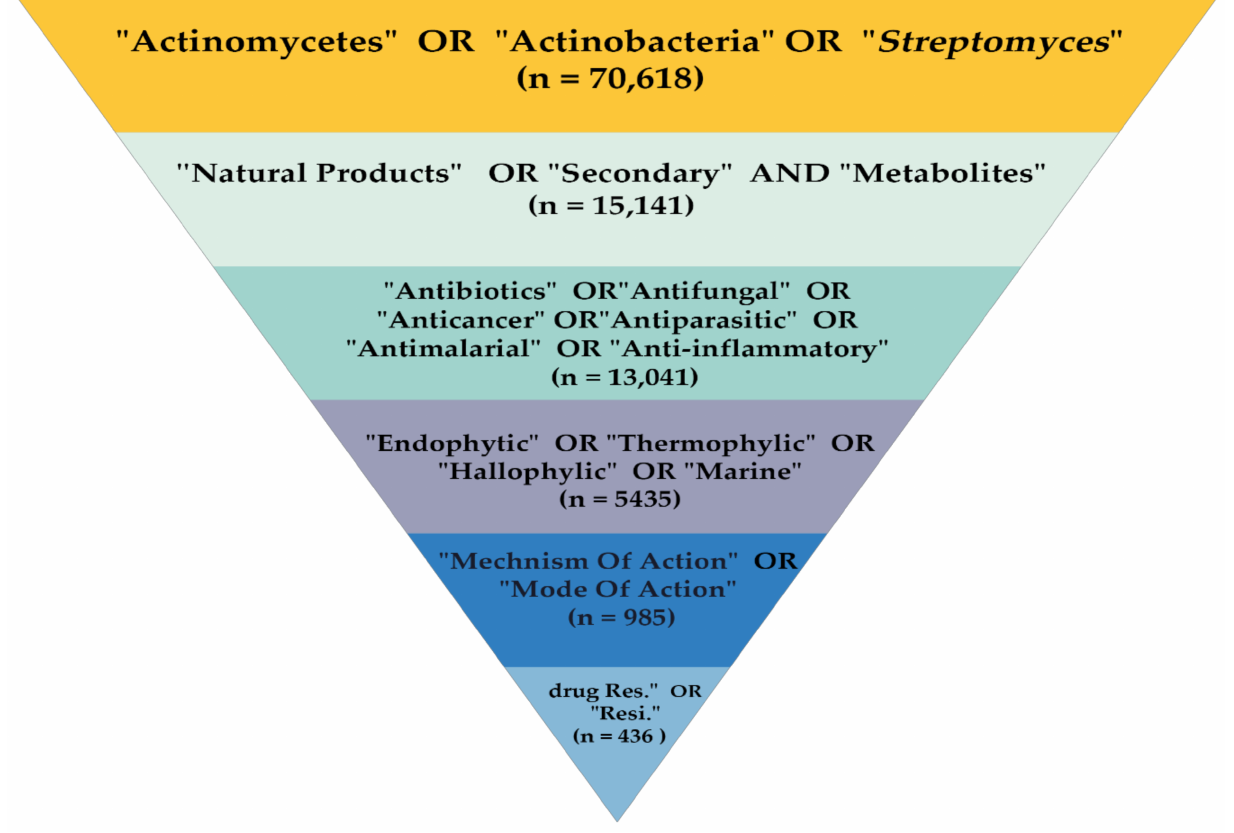
Figure 1. Phases of the review protocol. The process involved six main steps using the general keywords “Actinomycetes” OR “Actinobacteria,” OR “ Streptomyces”